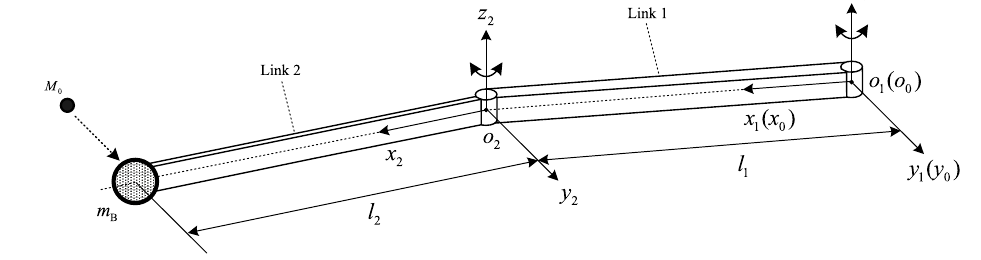
Fig. 4. Schematic of the flexible manipulator without vibration absorber.